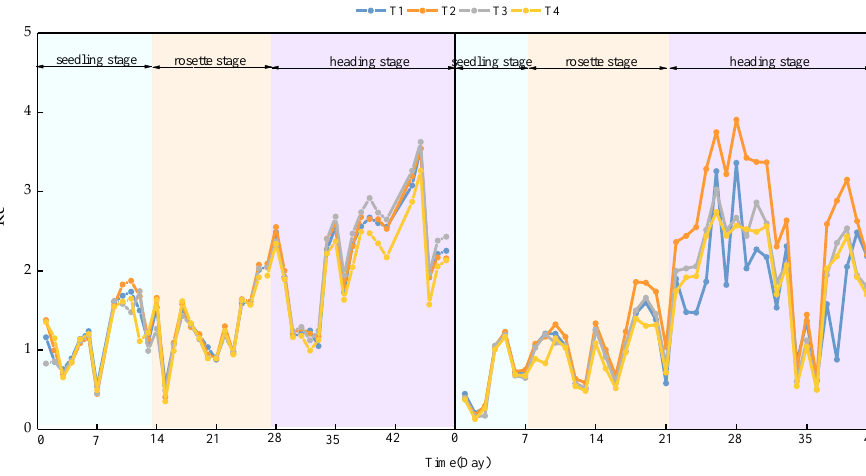
Figure 12. K c changes under different water treatments. Table 4 indicates that the K c of lettuce gradually increases during the entire growth period. The water consumption of lettuce varies significantly in different growth stages, and the water consumption modulus gradually increases as the growth period pro-